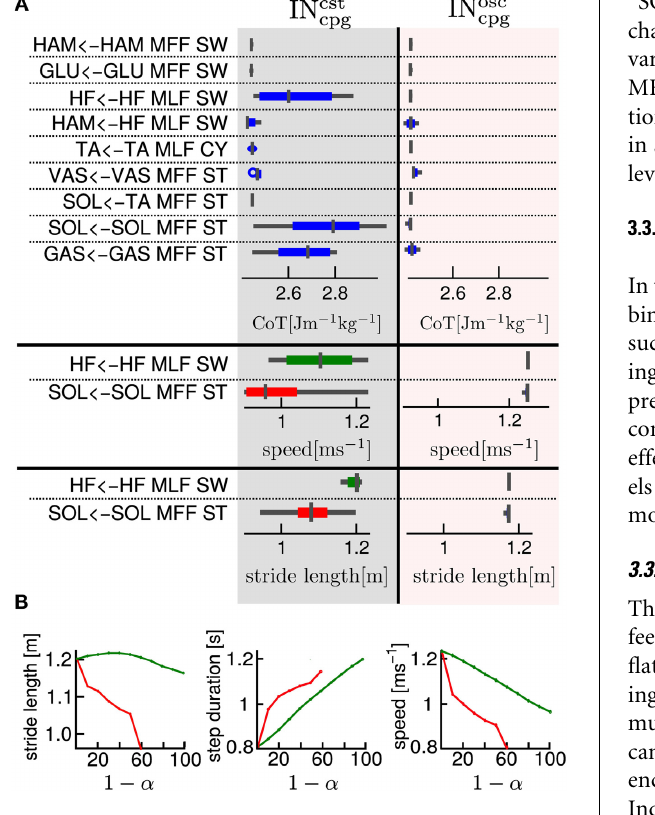
FIGURE 6 | (A) One by one feedback and feedforward combination effects on cost of transport, stride length and speed, for gait number 1. The first column gives the name of the feedback pathway considered. The second and third columns show for an IN sen -IN cst cpg and an IN sen -IN osc cpg respectively,